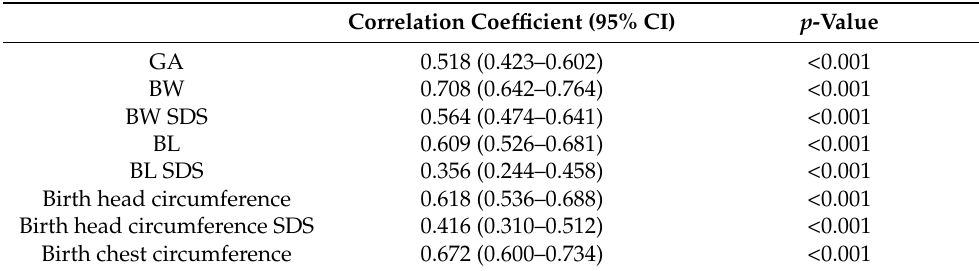
Table 3. Association between insulin-like growth factor-1 levels and gestational age or anthropometric values at birth.